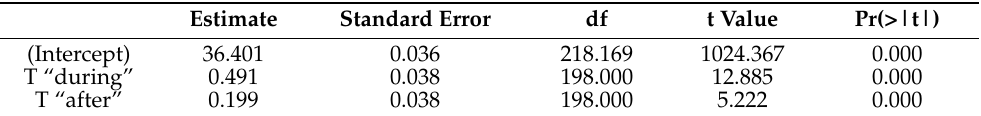
Table 1. Differences between the forehead temperature values depending on the time at which the measurement was performed (the temperature before starting the dental procedure is taken as reference, “before”).